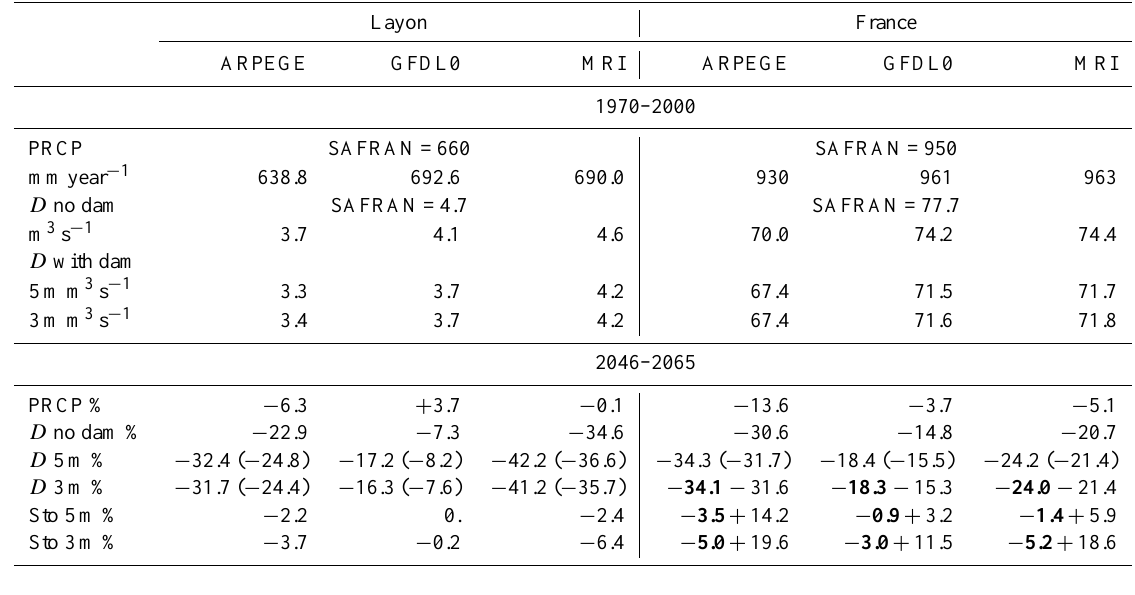
Table 3. Simulated present-day precipitation and river flow according to the climate models and projections for 2050. PRCP: annual precip- itation; D no dams: annual discharge without small farm dams; D 3 and D 5m: annual discharge with small farm dams covering and area of 0.5%, with a dam catchment of 50%, and the 3-month and 5-month filling periods, respectively. The changes in river discharge in 2050 were computed using two references, with (in brackets) or without dams in present day; Sto: mean annual maximum storage over maximum storage of the dams for the two filling periods. Two values are computed over France: the average is computed over the whole of France and, in bold, only on the grid cells below 1250m. The results obtained using the Safran analysis are given as a baseline.